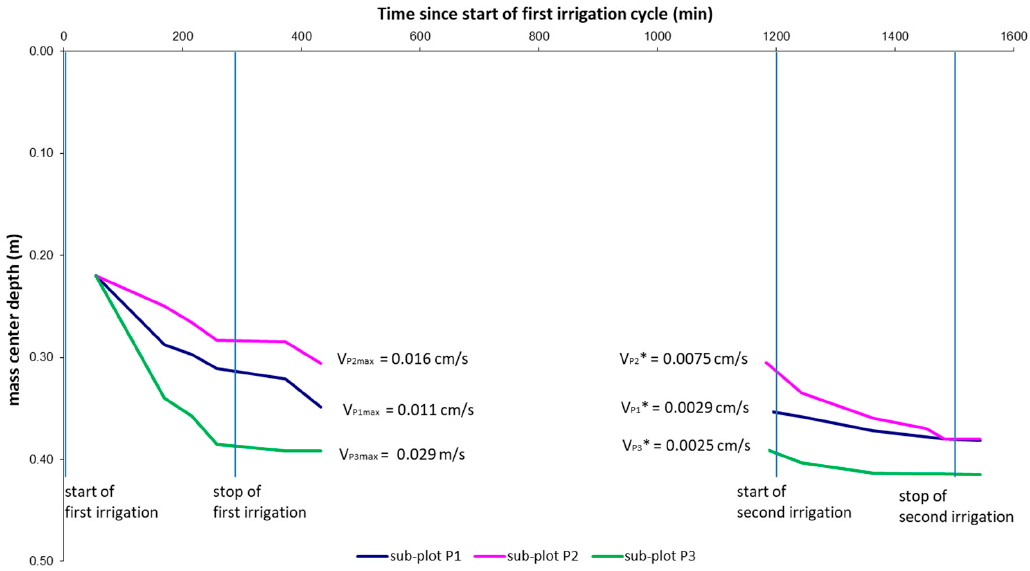
Figure 8. Depth of the mass center reached in the three sub-plots after two irrigation cycles.